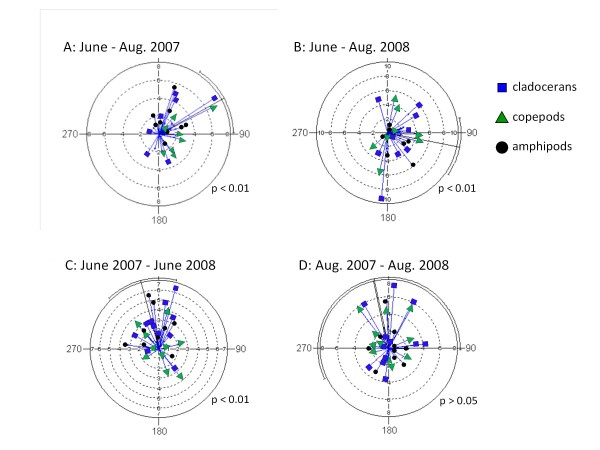
Results of circular statistics to quantify direction and magnitude of temporal variation (Schmidt et al., 2007) of δ13C and δ15N values in the 20 study lakes for selected bioata. Periods of temporal change were either seasonal: (A) June to August 2007, (B) June to August 2008, or annual: (C) June 2007 to June 2008 (D) August 2007 to August 2008. The arrow diagrams represent the directional changes in δ13C and δ15N values between time intervals for cladocerans (blue square), copepods (green triangle), and littoral macroinvertebrates (black circle) in each individual lake. Blue arrows represent the angle of change (θ) and the length of the arrow represents the magnitude of change (vector). The mean vector of change (across all lakes and taxonomic groups, μ) is represented by the black line from the origin to the outside of the diagram. The curved line at the end of the mean vector line on the outside of the graph is the 95% confidence interval of the mean vector of change, and p-values indicate if the direction of change was significant for a particular time period. For time period (A) a significant shift was observed, which was associated with increases in both δ13C and δ15N. For time periods (B) and (C), significant shift were associated with either δ13C or δ15N, respectively, and for time period (D) no significant changes were recorded.